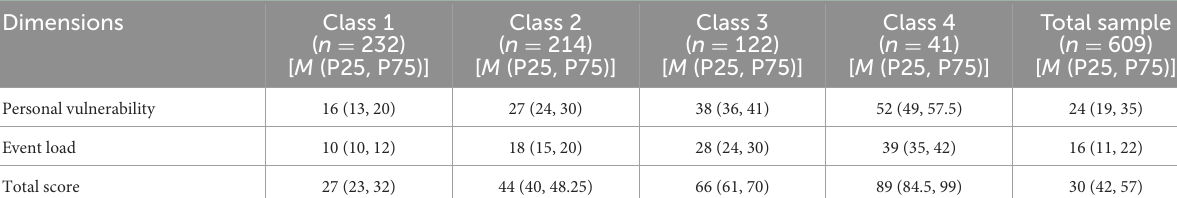
TABLE 3 SOS scores for different stress load classes ( n = 609).